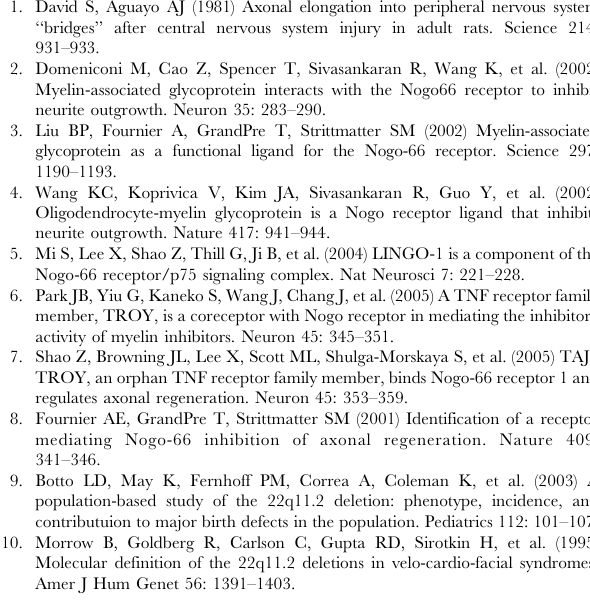
Figure S1 Brain histology in Rtn4r-deficient mice: Representa- tive microphotographs from Nissl staining of coronal sections through the cerebral cortex (A, B), anterior-dorsal hippocampus (C, D) and corpus callosum (E, F) from 8-wk-old Rtn4r-deficient mice ( 2 / 2 ) and their wild-type littermates ( + / + ). (G, H) Coronal sections through the cerebral cortex of Rtn4r recombinant mice crossed with Thy1-YFPH expressing transgenics. Scale bars represent 0.4 mm. (I) Average cell density of the retrosplenial agranular cortex at Bregma 2 2.18 mm, 2 1.70 mm, and 2 1.22 mm. (J) Average thickness of the retrosplenial agranular cortex. (K) Average thickness of the corpus callosum. All data are represented as mean 6